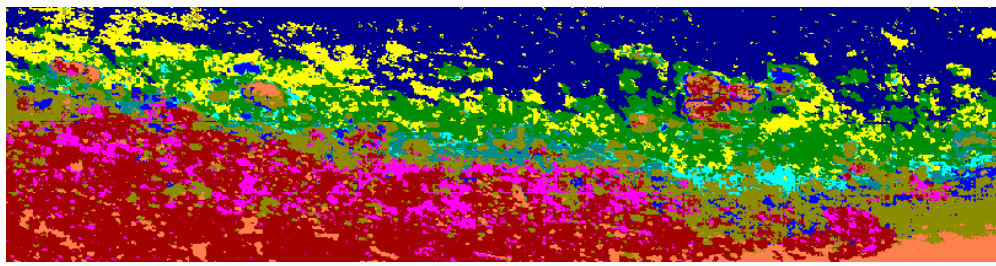
Figure 22. Support vector machine (SVM) material classification for Pandora Reef with spume regions marked in Figure 5 excluded.